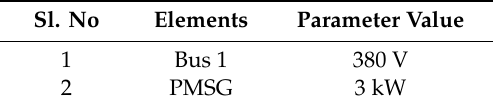
Table 1. AC network parameters.